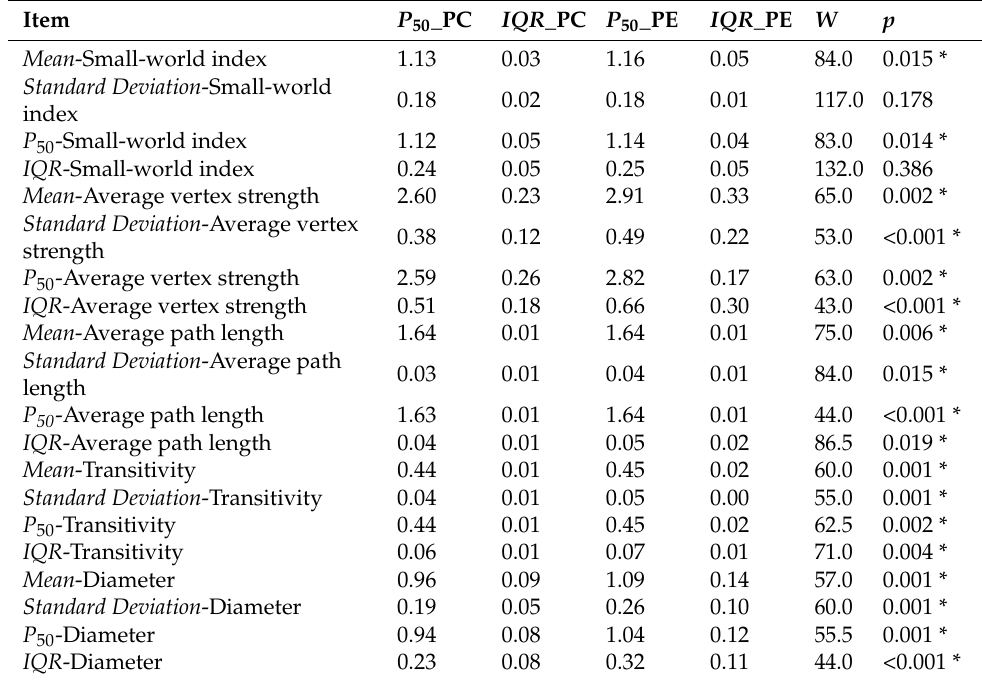
Figure 4. ROC curves with the highest accuracy rate under the two datasets. ( a ) iCOH method under the full-frequency band; dynamic network; original sequence EEG signals dataset; decision tree method; AUC = 1.000. ( b ) iCOH method under the full-frequency band; dynamic network; split segment EEG signals dataset; support vector machine method; AUC = 0.981. Table 3. Univariate analysis of dynamic network